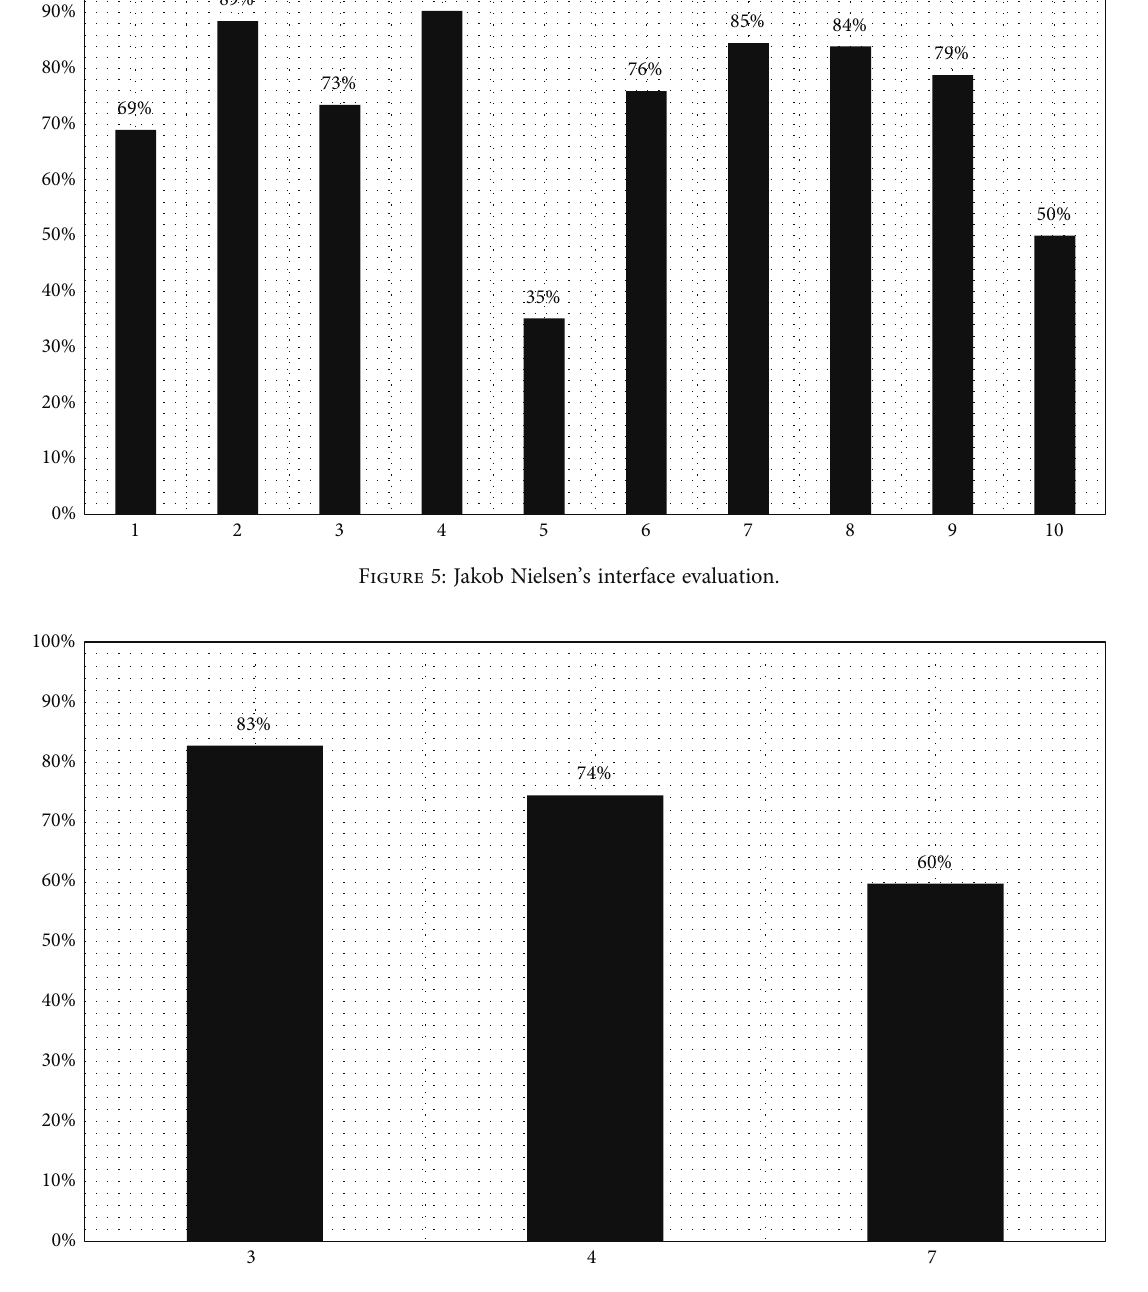
Figure 6: Shneiderman ’ s interface